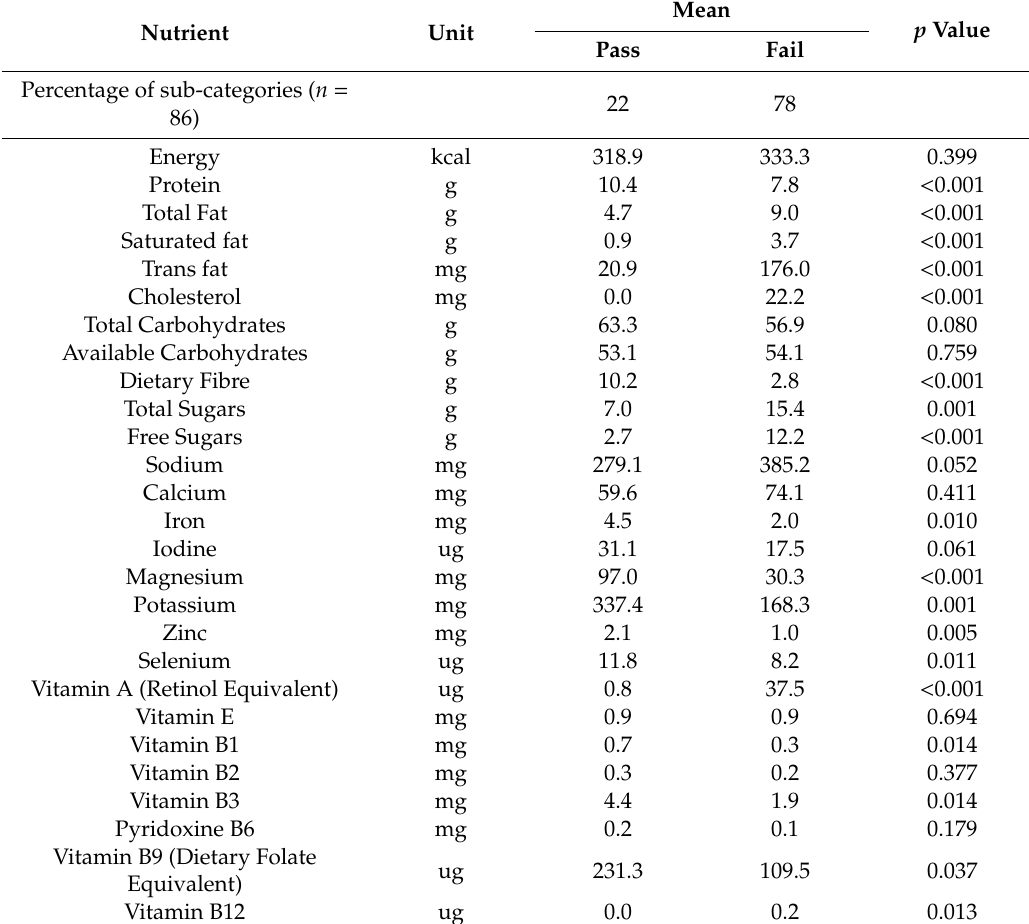
Table2. Comparison of meannutrient composition of carbohydrate-based packagedfood sub-categories from AFCD-1 that passed or failed all of the three carbohydrate